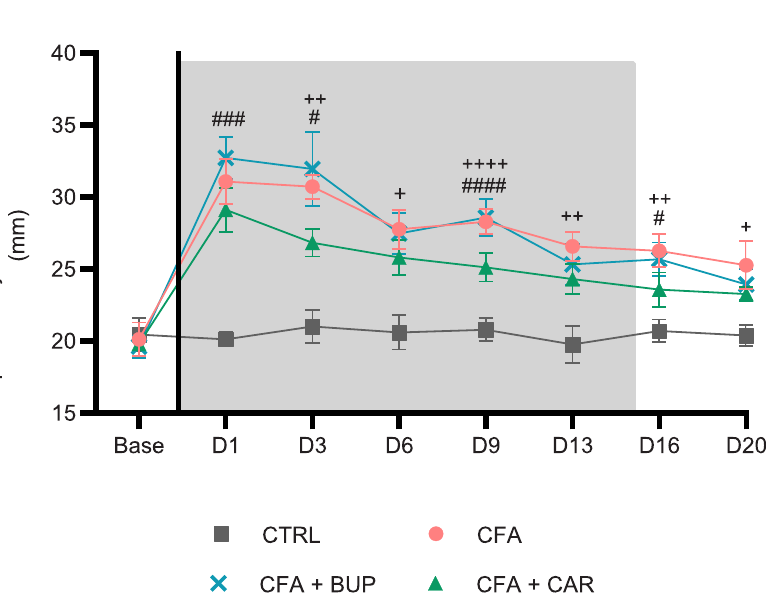
Fig 4. Circumference measurements of the ipsilateral ankle. The plus ( + ) represents a statistically significant difference between CFA + CAR and CFA at + p < 0.05, ++ p < 0.01 and ++++ p < 0.0001. The hash ( # ) represents statistically significant difference between CFA + BUP and CFA + CAR at # p < 0.05, ### p < 0.001 and #### p < 0.0001. For all graphs: base = baseline values, D = day, the line represents the day of analgesic treatment initiation (D0) and the grey area represents the treatment period (15 days). For all data: presented as mean ± SEM. All groups, n = 8, male Sprague Dawley rats.